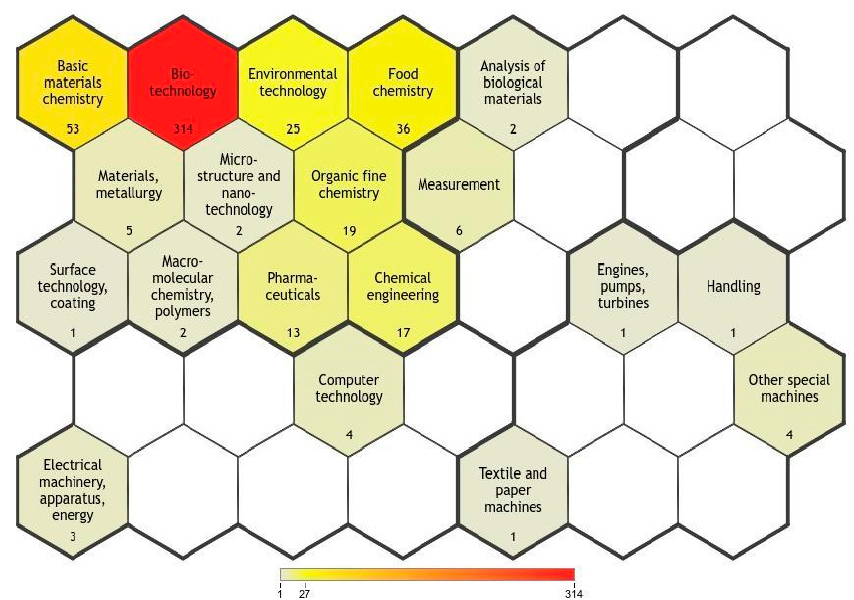
Figure 3. Technological domains involved in the prospected codes. The numbers show the quantity of documents in each technological domain.